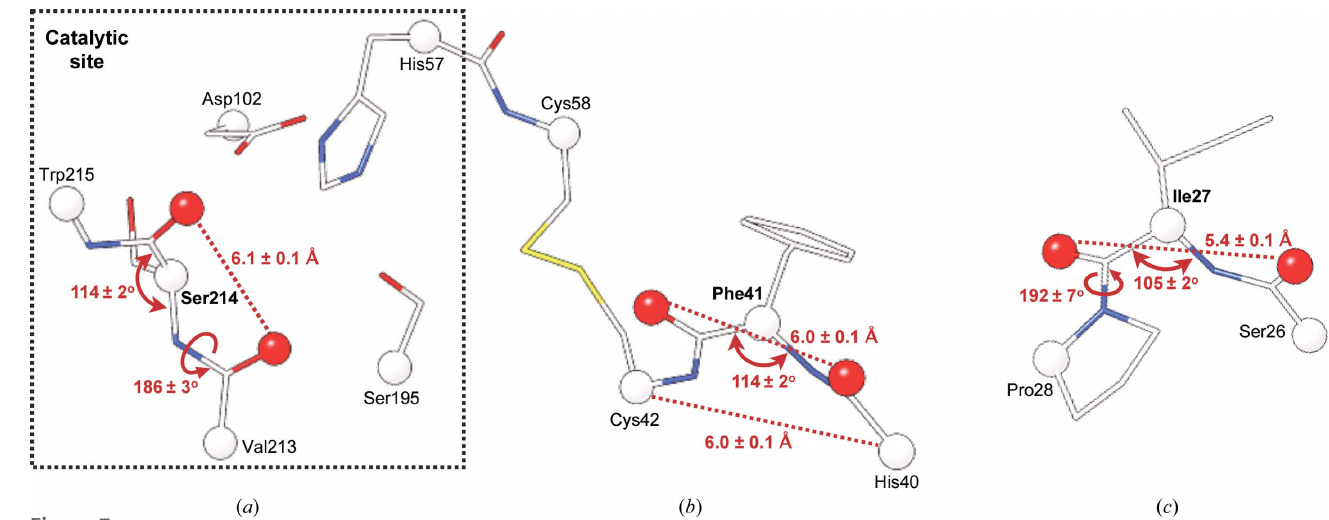
Figure 7 The geometrical characteristics of strained residues in trypsin. ( a ) Ser214 in the catalytic site, ( b ) Phe41 close to the active site and ( c ) Ile27 far from the catalytic